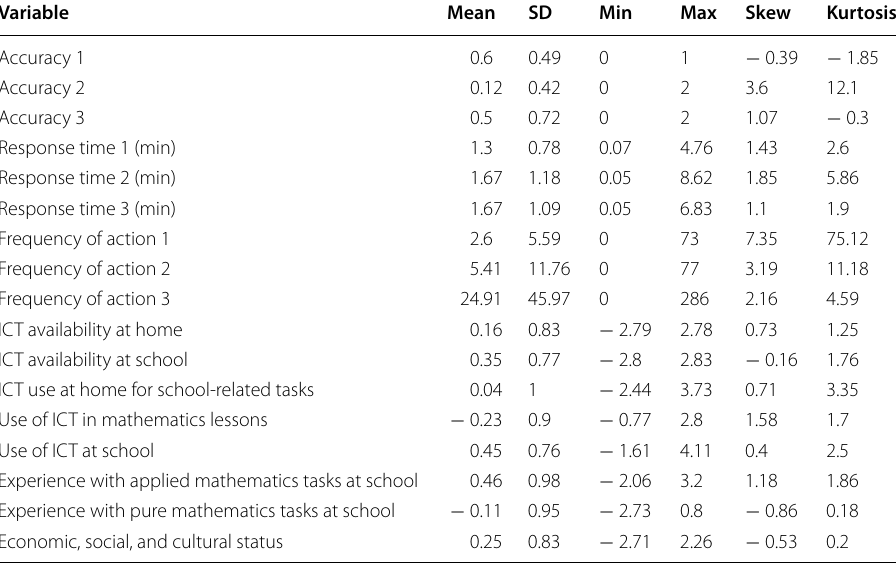
Table 12 Descriptive analysis of the indicators in their original metrics for Sweden